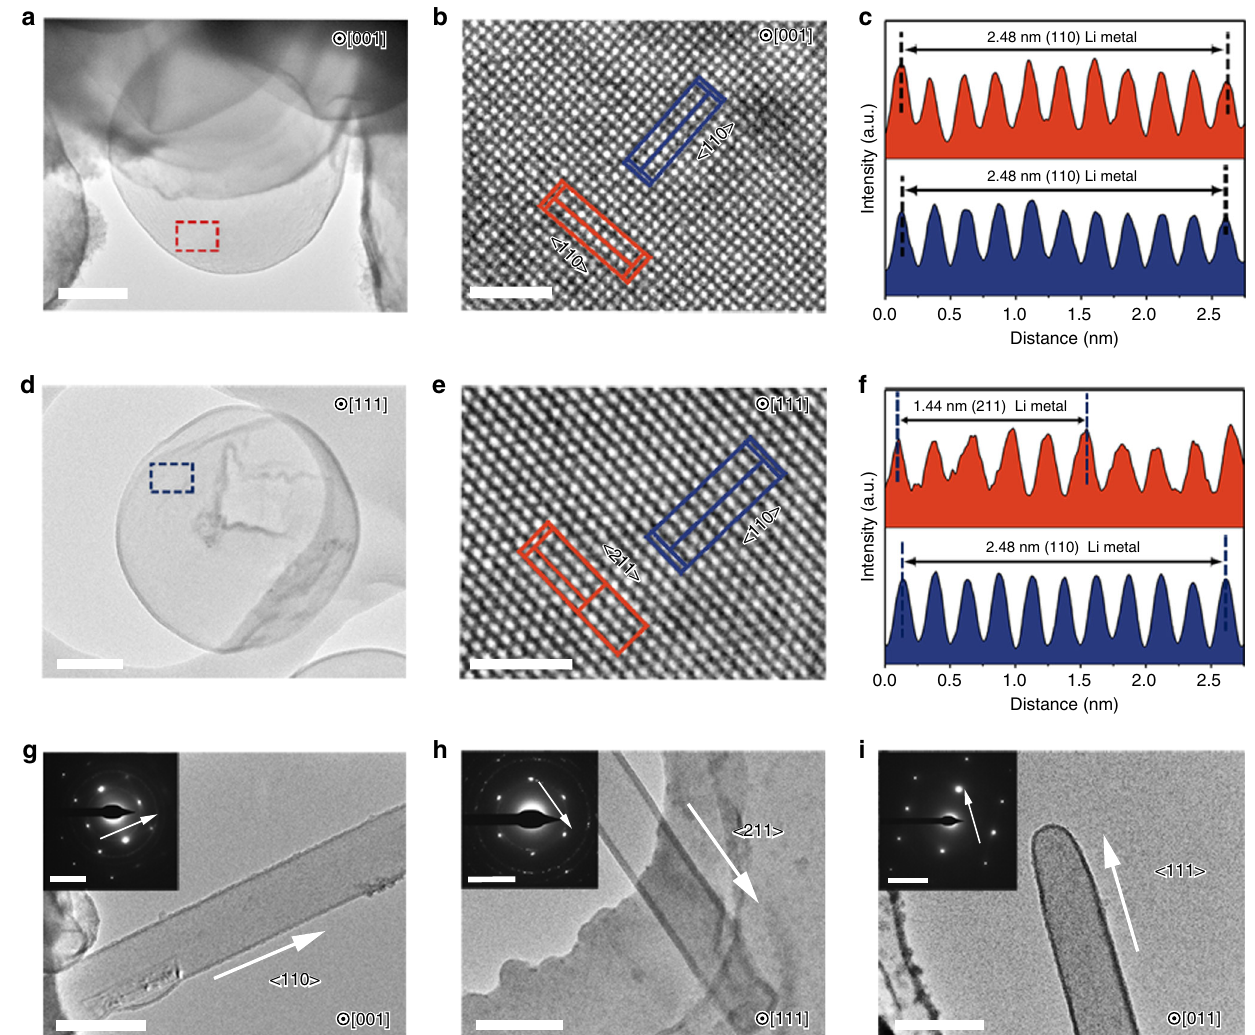
Fig. 3 TESM-induced dendritic suppression mechanism. a , d Cryo-TEM images of Li microspheres deposited in the presence of TESM in ether-based electrolytes. b , e The corresponding HRTEM images of the marked area in a and d along the [001] and [111] zone axes, respectively. c , f The measured lattice spacing in b and e , respectively. g – i Cryo-TEM images of Li dendrites formed in ether-based electrolytes without TESM and their corresponding SAED patterns (insets) growing along the ( g ) <110>, ( h ) <211>, and ( i ) <111> directions. Scale bars: ( a , d ) 500 nm, ( b , e ) 2 nm, ( g – i ) 500 nm, and insets 5 nm − 1